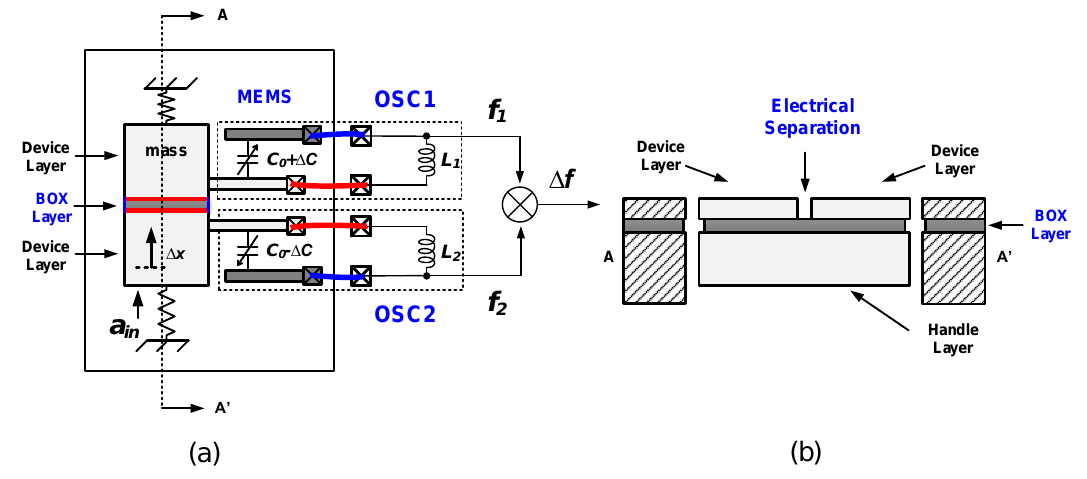
Figure 4. Electrical separation of MEMS proof mass: ( a ) top view; ( b ) cross-section of ( a ) at AA (cid:48)